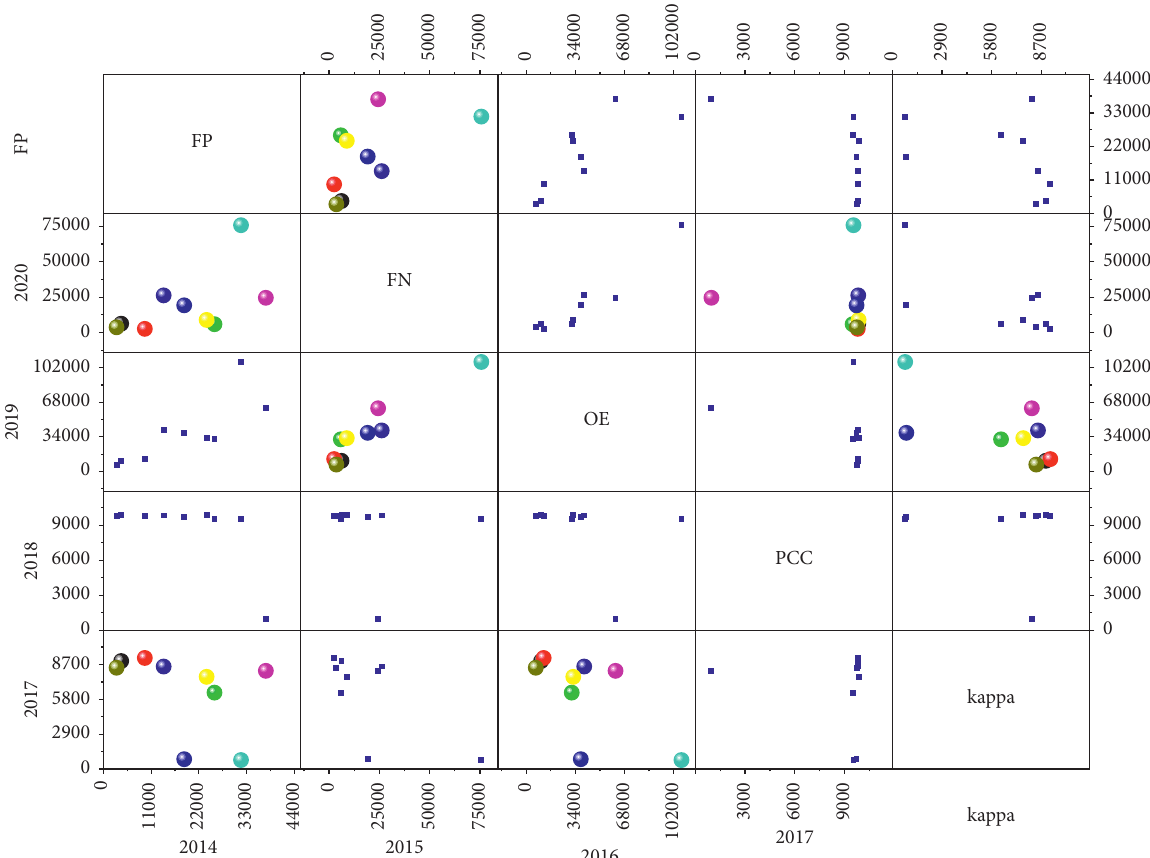
Figure 7: Relationship between subsystem orderliness and composite system